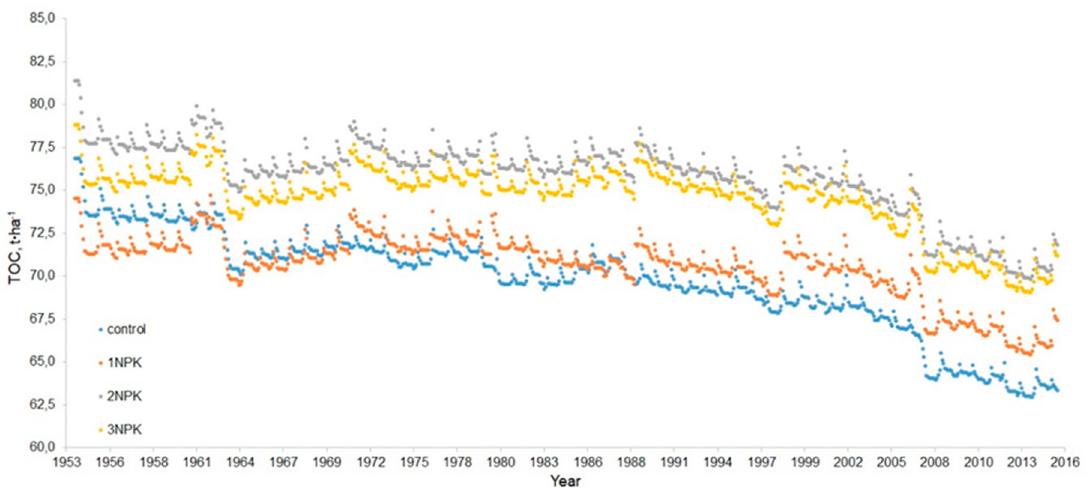
Figure 4. Simulated changes in total organic C (TOC) stock at four treatments for the period from 1954 to 2015. to 2015. Table 3. Simulated changes in SOC stocks in the upper 20 cm of four treatments of the experiment for the period from 1954 to